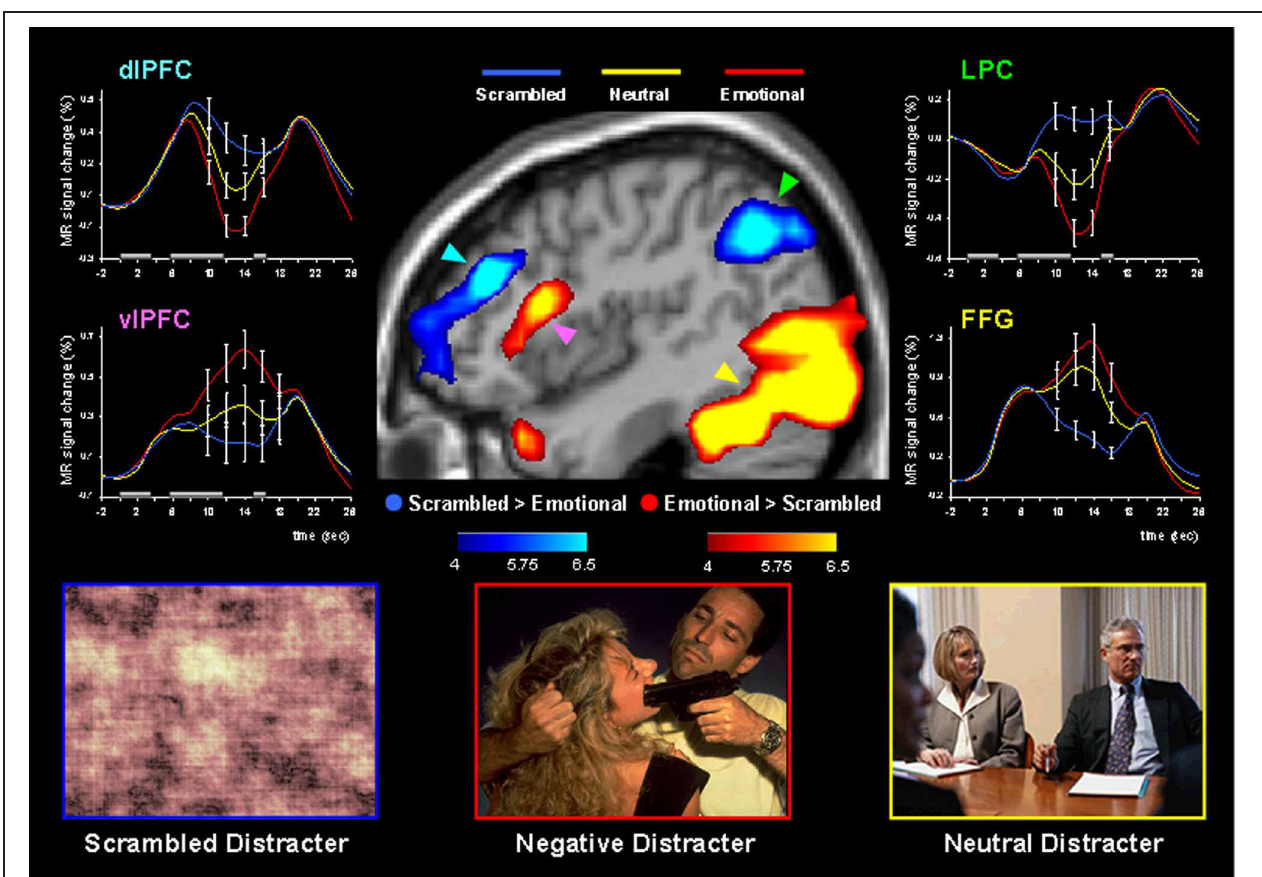
FIGURE 3 | Dissociable patterns of brain activity in the dorsal ColdEx and ventral HotEmo systems linked to impaired working memory performance in the presence of emotional distraction. Emotional distracters produced the most disrupting effect on the activity during the delay period of a working memory task in a set of dorsal brain regions associated with executive processes (the blue clusters) while producing the most enhancing effect on activity in a set of ventral brain regions associated with emotion processing (the red clusters). The central image shows activation maps of the direct contrasts between the most versus least distracting conditions (i.e., emotional vs. scrambled pictures), superimposed on a